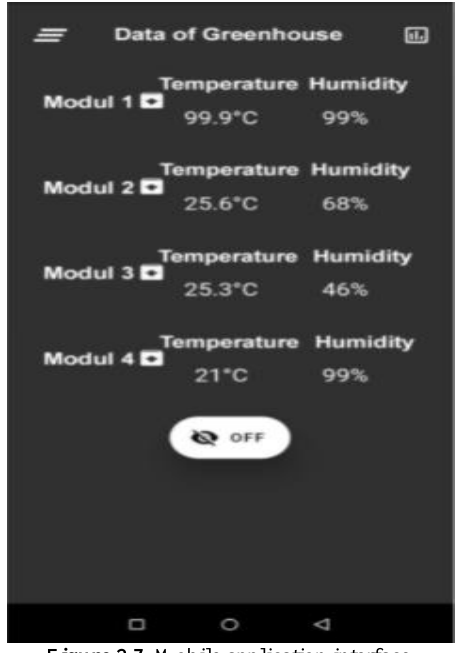
Figure 2.7 . Mobile application